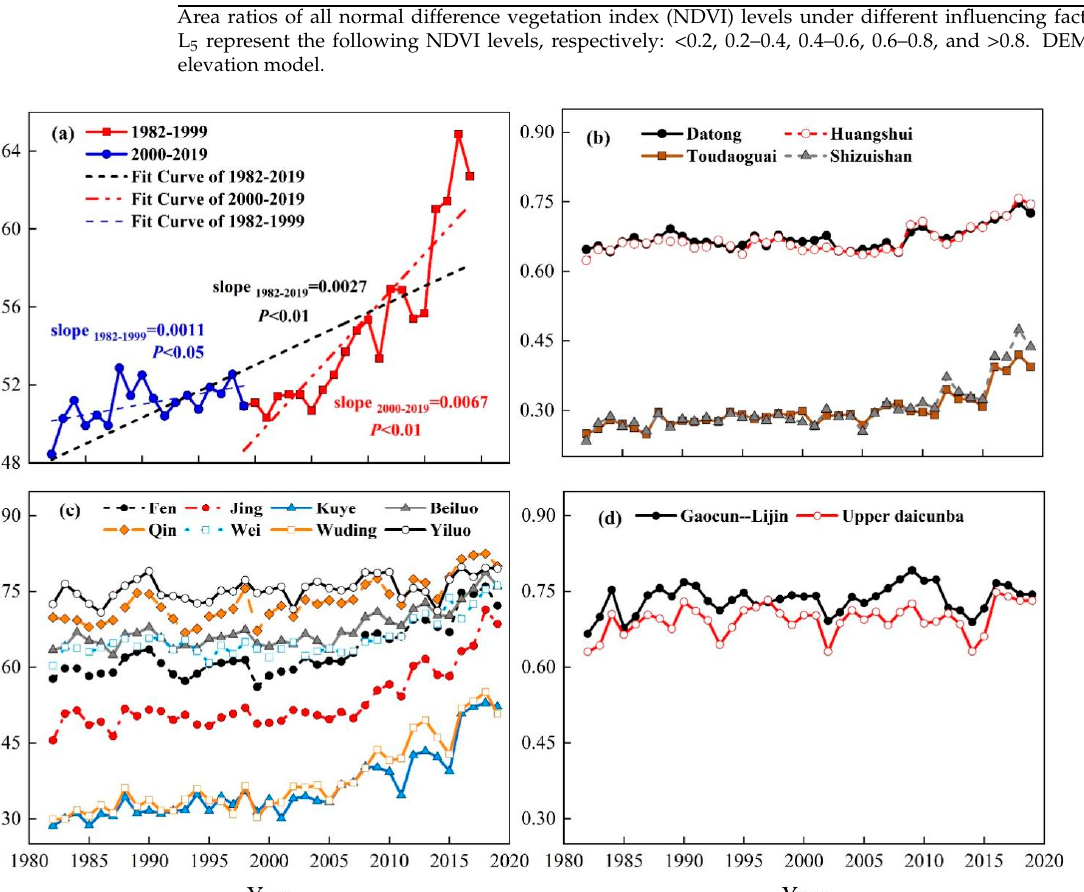
Figure 5. Spatial change speed patterns of three periods in the Yellow River Basin (YRB). Change speed: slope of linear fit over a period of time. From the observations, in the YRB, low NDVI levels (L 1 –L 2 ) were converted to high NDVI levels (L 4 –L 5 ), quantitatively, and the low-level NDVI area decreased by 25.2% and the high-level NDVI area increased by 25.14% (Figure 6). However, the temporal variation in all NDVI levels in each sub-basin varied. In the UYRB, the areas shown in Figure 7a,b changed from high-level NDVIs to high-level NDVIs (L 4 –L 5 ), while for the areas shown in Figure 7c,d, low-level NDVIs converted to medium-level and high-level NDVIs (L 1 to L 3 and L 4 ) (Figure 7a–d). The MYRB NDVIs were all at medium–high levels: In the eight sub- basins, there were almost 0 L 1 areas, and L 2 areas changed to high levels. Except for the areas displayed in Figure 7g,k, the L 5 areas in the other sub-basins increased, and after the